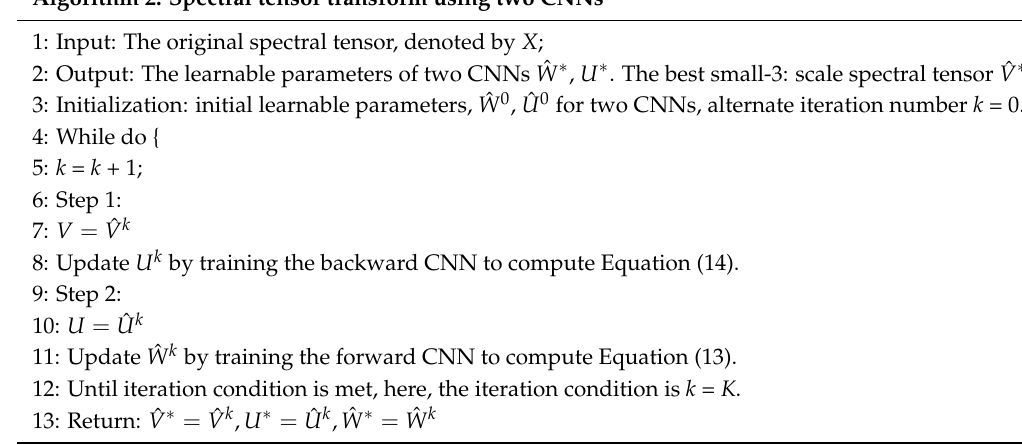
Algorithm 2: Spectral tensor transform using two CNNs